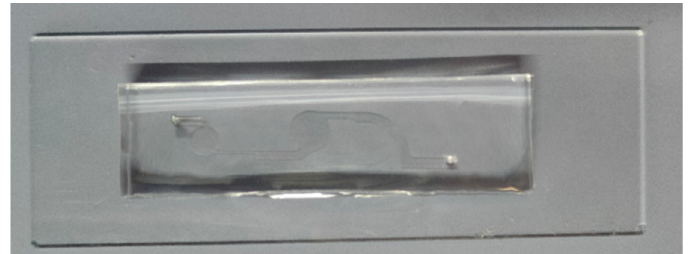
Figure 3. Chip physical map.